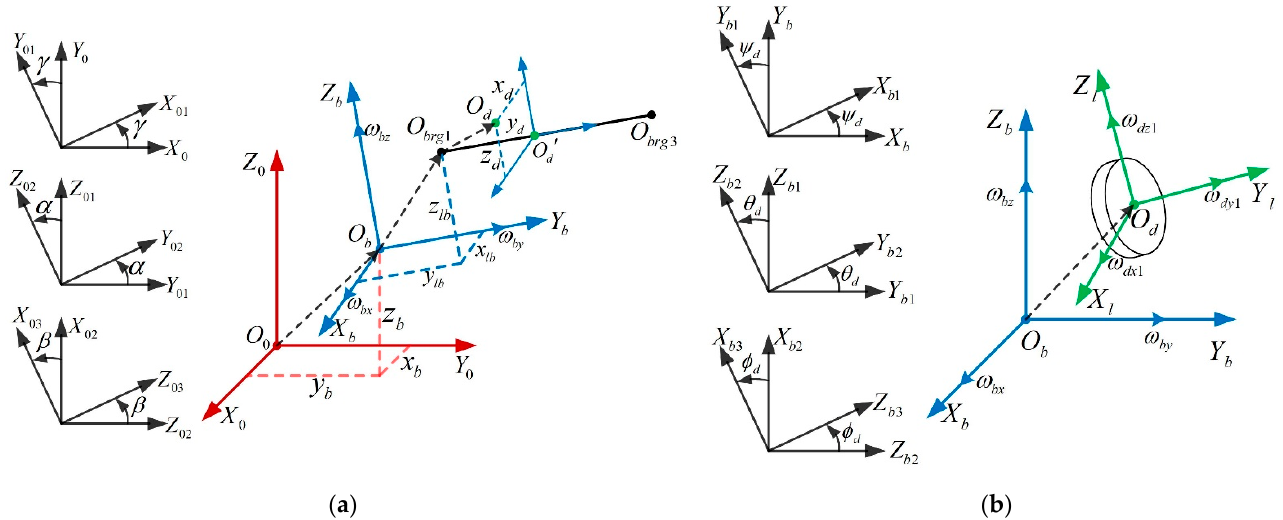
Figure 2. Derivation of the linear and angular velocity of the disk: ( a ) Linear velocity of the disk; ( b ) Angular velocity of the disk.